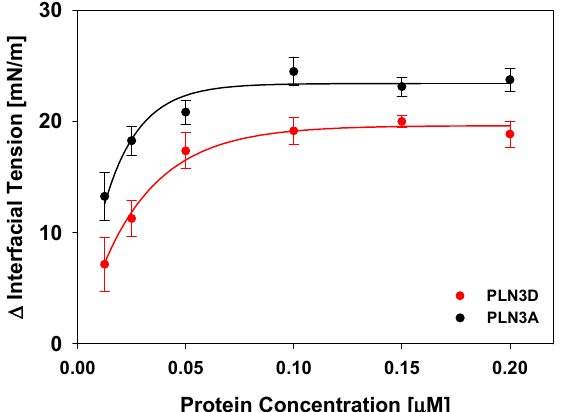
Figure 3. Surface pressure of the C-terminus of perilipin 3 (PLN3D, red) and full-length perilipin 3 (PLN3A, black) at the oil-aqueous interface. Each point is the average of three independent experiments in which a triolein drop is formed in buffer and allowed to equilibrate before either the full-length or truncated perilipin 3 is added at a set concentration and allowed to insert. Values reported here are the change in interfacial tension between the initial triolein in buffer value and after protein is added. Error bars are the standard deviations calculated between the three independent drops.